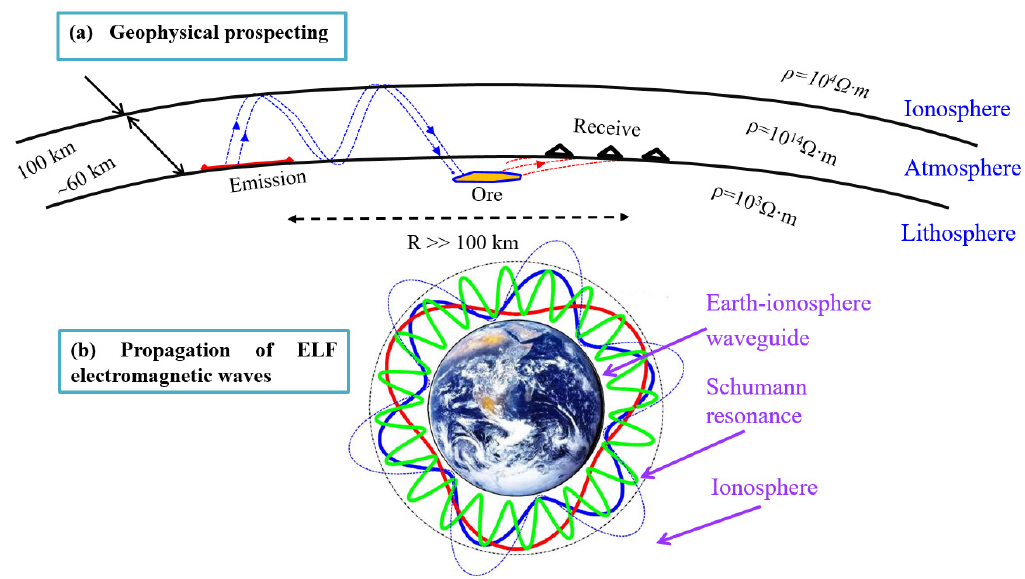
Figure 1. ( a ) Artificial electromagnetic signals reflected or refracted from the ionosphere back to the Earth’s surface; ( b ) brief model of the propagation of ELF-EM waves excited in Earth–ionospheric waveguide: the dotted line represents the lower boundary of the ionosphere, and the solid line represents the schematic diagram of the propagation paths of electromagnetic waves with different frequencies.